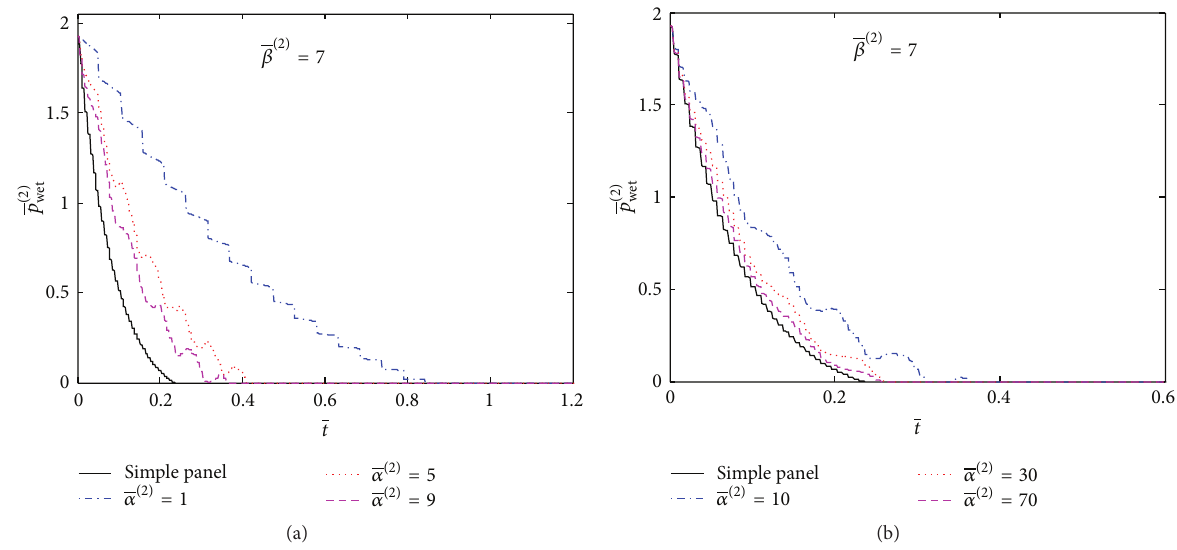
(2) wet forthe panel with stiffener (T-shaped)with theparameters